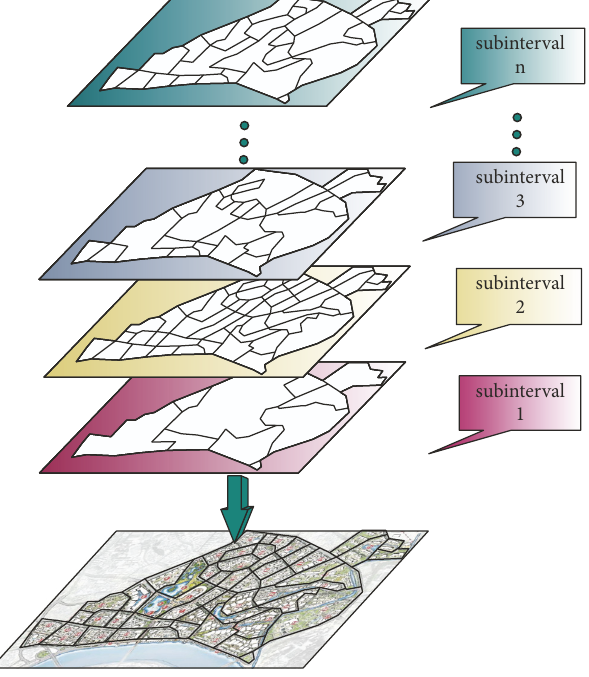
Figure 5: Full-dynamic